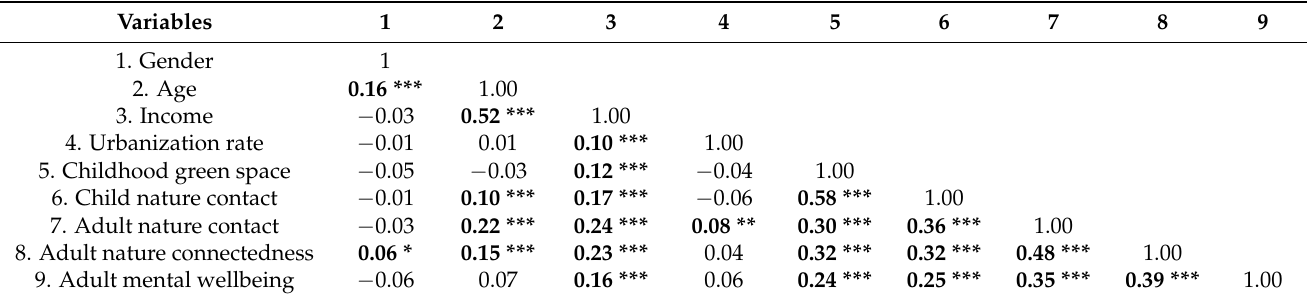
Table 2. Correlations (Spearman and point-biserial) between the measurements.